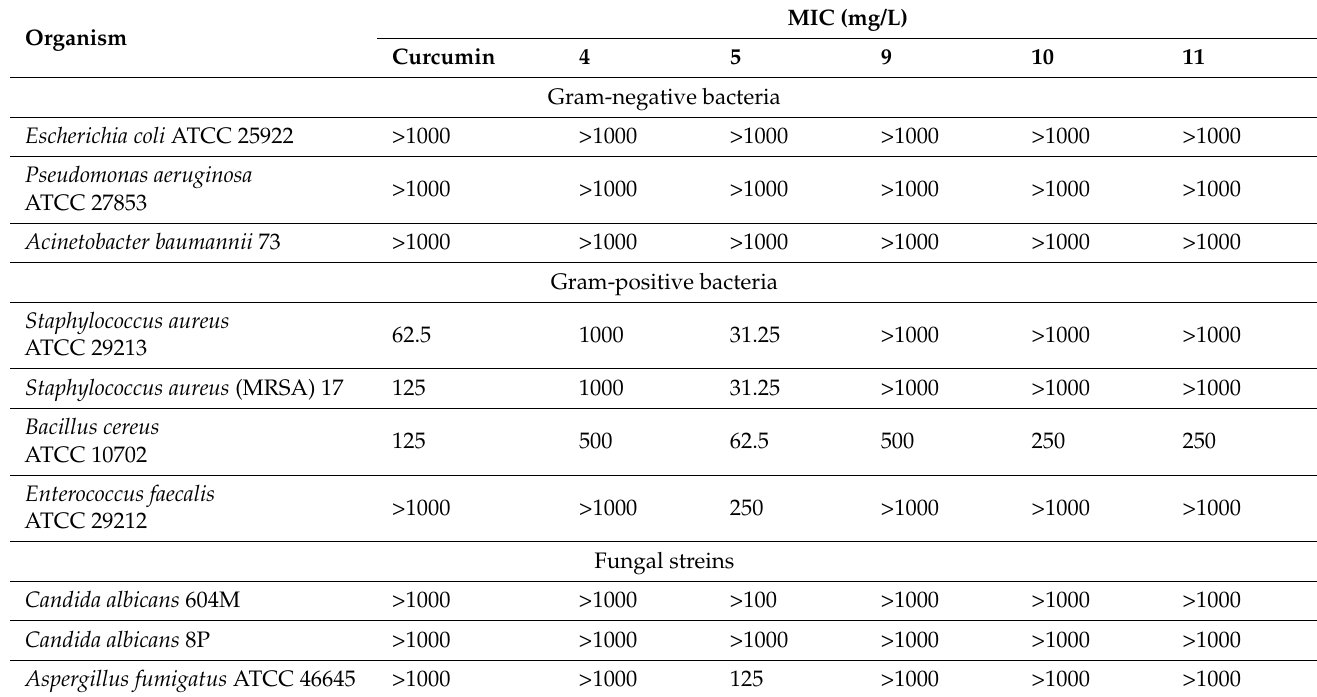
Table 1. In vitro comparative assessment of the antimicrobial activities of curcumin and its boron clusters